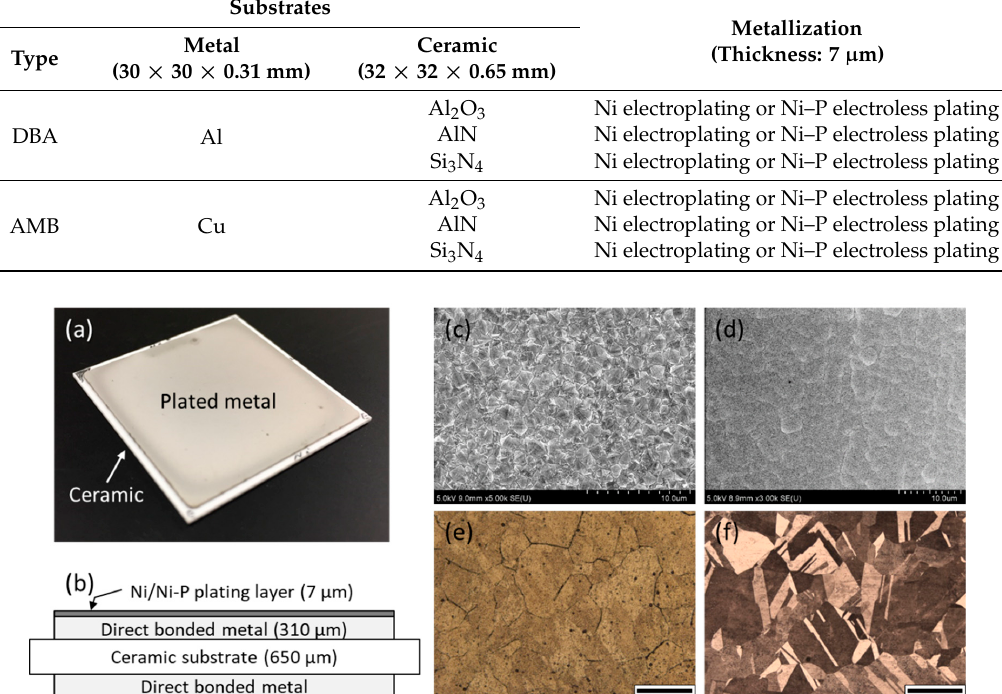
Table 1. Materials and dimensions of multilayered